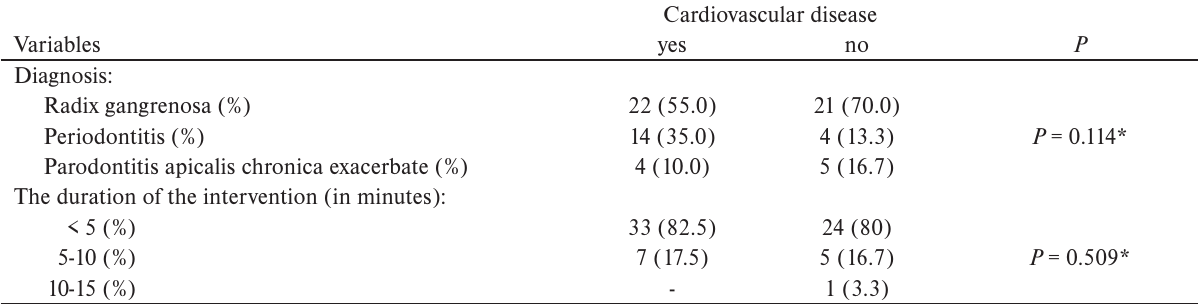
Table 2. Distribution of diagnosis and duration of intervention in both groups.